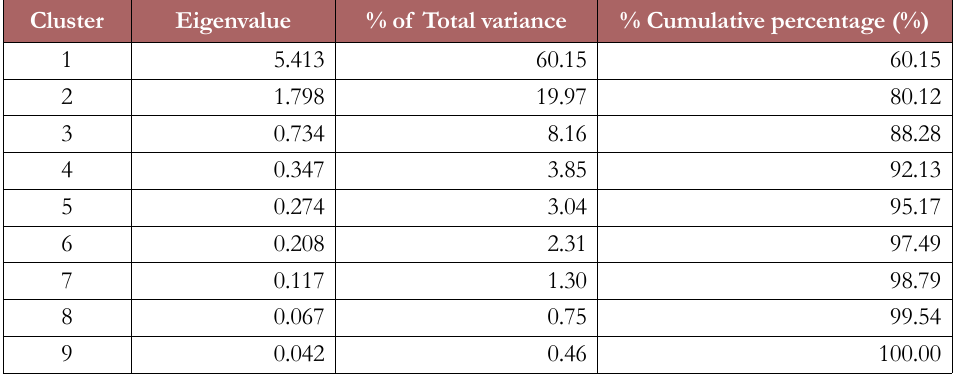
Table 4. The computed eigenvalues